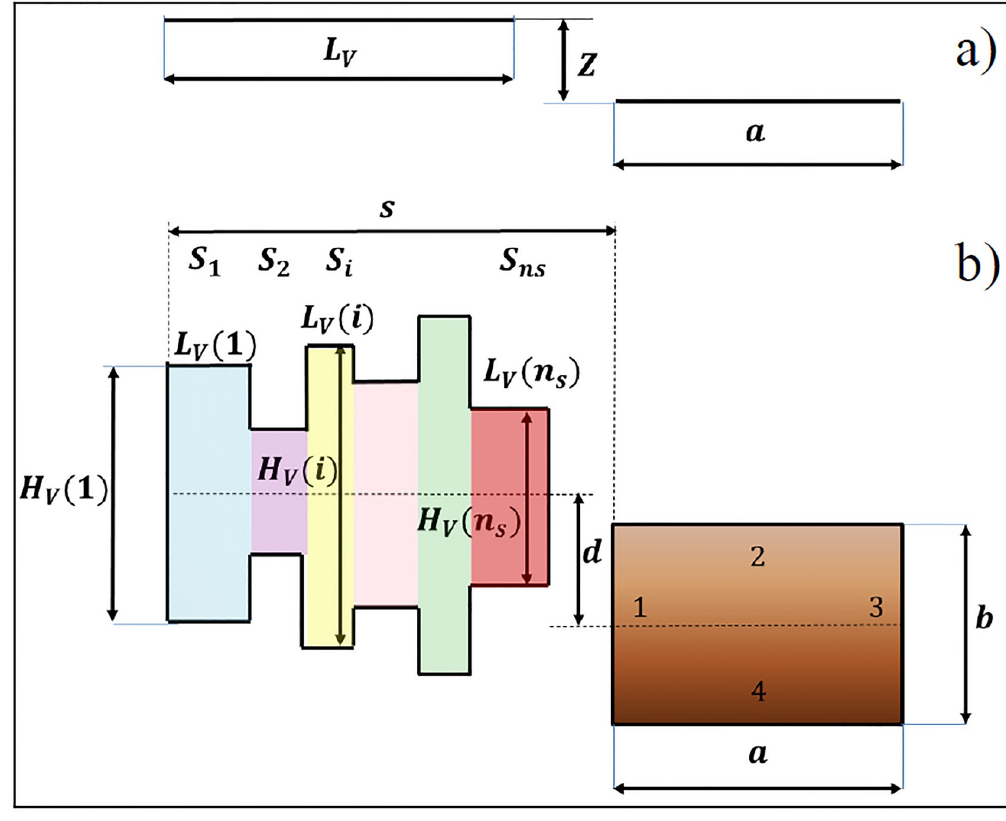
Fig 11. Representative diagram of the vehicle system for vehicles with polygonal forms and an arbitrary number of sections: (a) lateral view and (b) plan view.